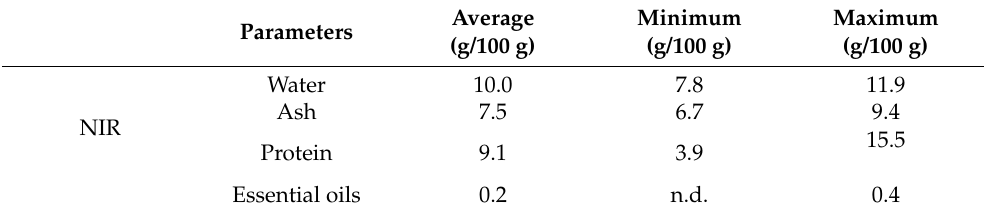
Table 2. Determination of water, ash, and protein in the coffee flowers (n =